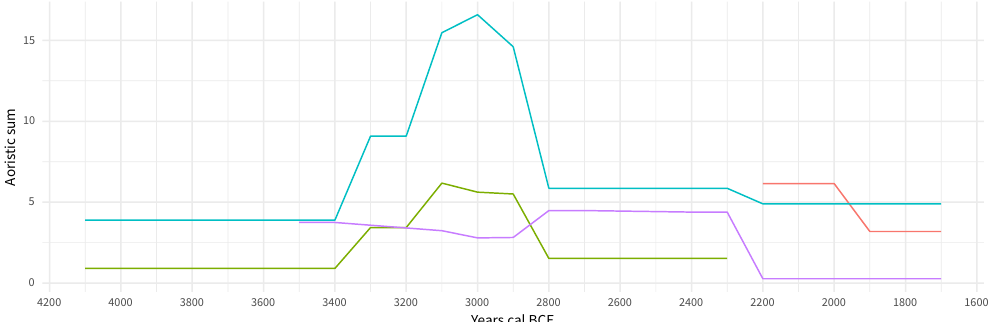
Figure 2. Diagram of the aoristic densities of settlements, burials, and depositions between 4100–1700 BCE in Wagrien (see also Table